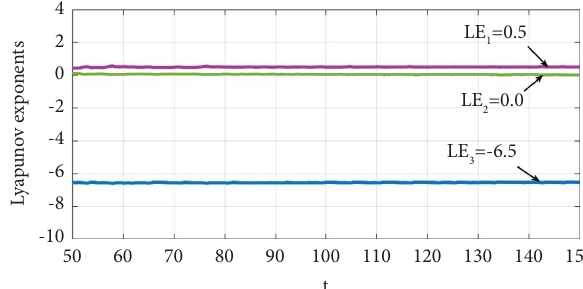
Figure 1: Evolution of the system Lyapunov exponents (i.e., LE) on the time interval 50 ≤ 0 < 150 at a � 2 , b � 7 , c � 5 , f � 8 ,g � 11 , and r � 4, where the steady-state Lyapunov exponents are LE � 0 . 0 , and LE � − 6 . 0 . 5 , LE 2 3